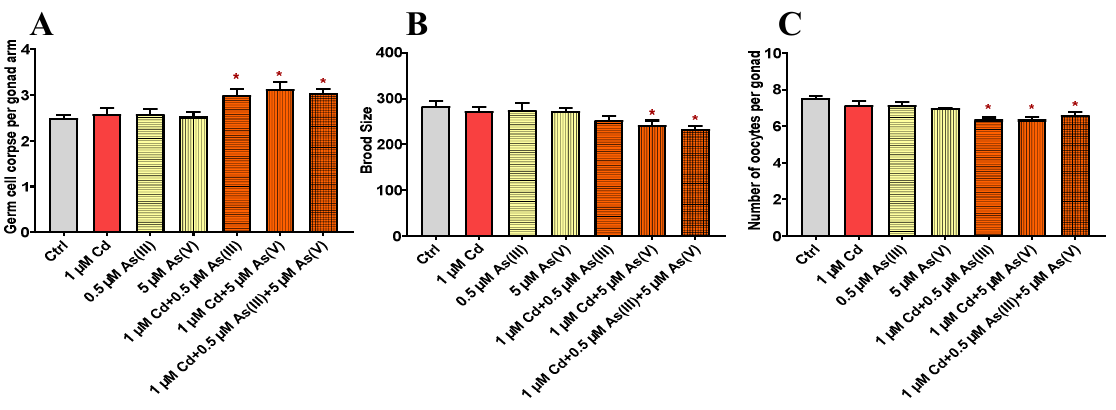
Figure 2. Effects of single and co-exposure to non-toxic concentrations of Cd, As(III), and As(V) on ( A ) germ cell apoptosis, ( B ) brood size, and ( C ) the number of oocytes. * means p < 0.05.